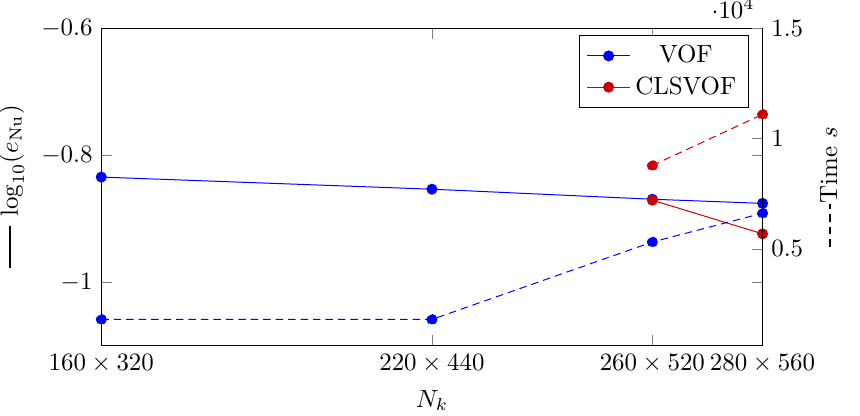
Figure 14. (Solid lines) Logarithmic representation of the error in which e Nu is the L2 norm of error for Nusselt number calculation. (Dashed lines) Computation time study for 2D film boiling using VOF and CLSVOF techniques at various grid